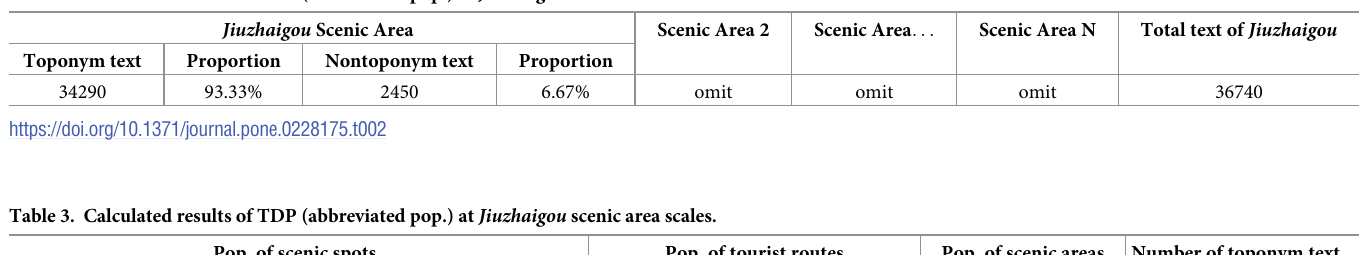
Table 2. Calculated results of TDP (abbreviated pop.) at Jiuzhaigou tourist destination scales.